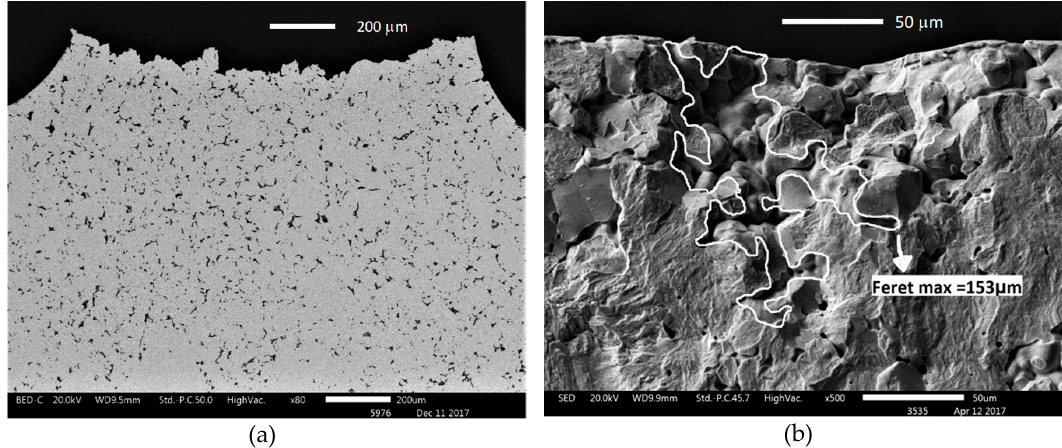
Figure 9. Fractographic inspections of DDH: ( a ) crack path (SEM), ( b ) crack initiation site (SEM).